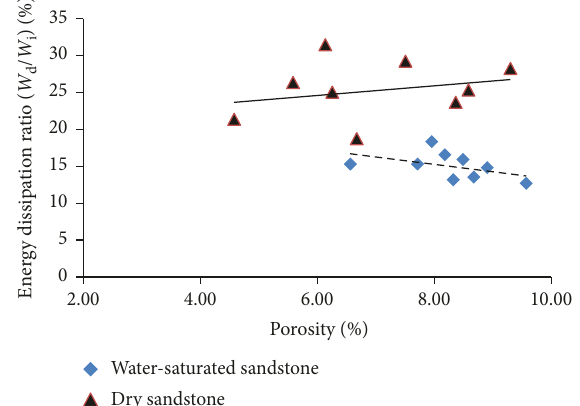
Figure 8: Relationship between porosity and energy dissipation